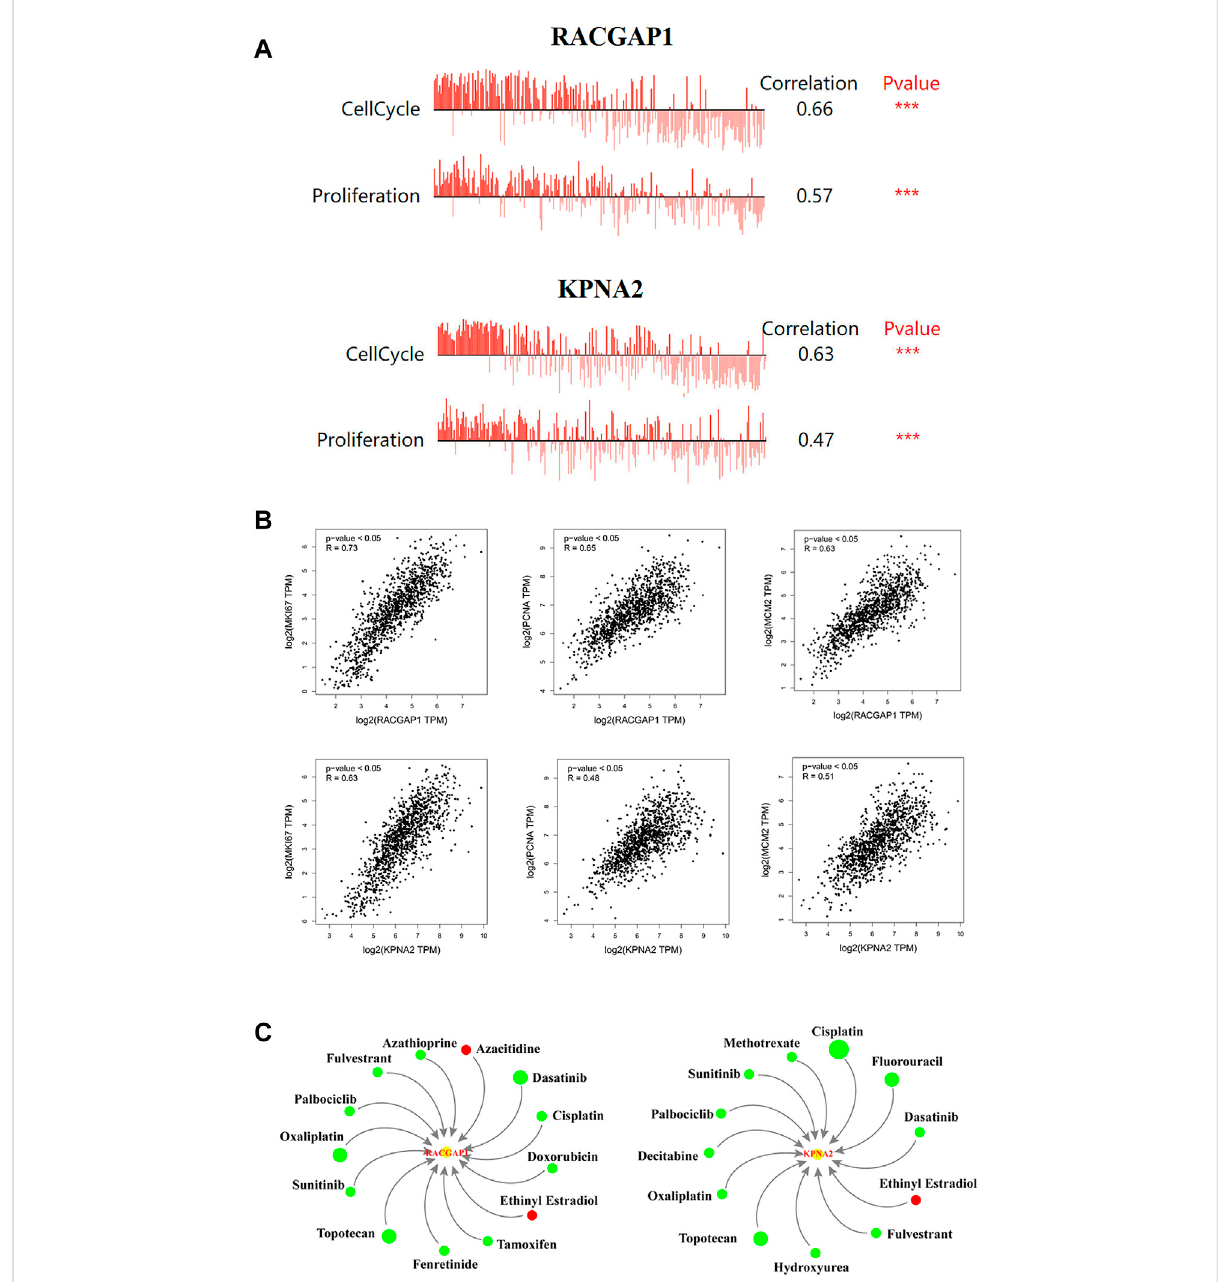
FIGURE 6 Biologicalfunctionsofprognosis-relatedgenes. (A) thebiologicalfunctionsoftwoprognosis-relatedgenesinbreastcancer. (B) thecorrelation prognosis-related genes and proliferation markers. (C) Gene-drug interaction network. Green circles: the drugs could reduce the expression of the twogenes.Redcircles:thedrugscouldelevatetheexpressionofthetwogenes.Thesizeofcirclesinthenetworkrepresentsthesupportednumbers of references. *** p <